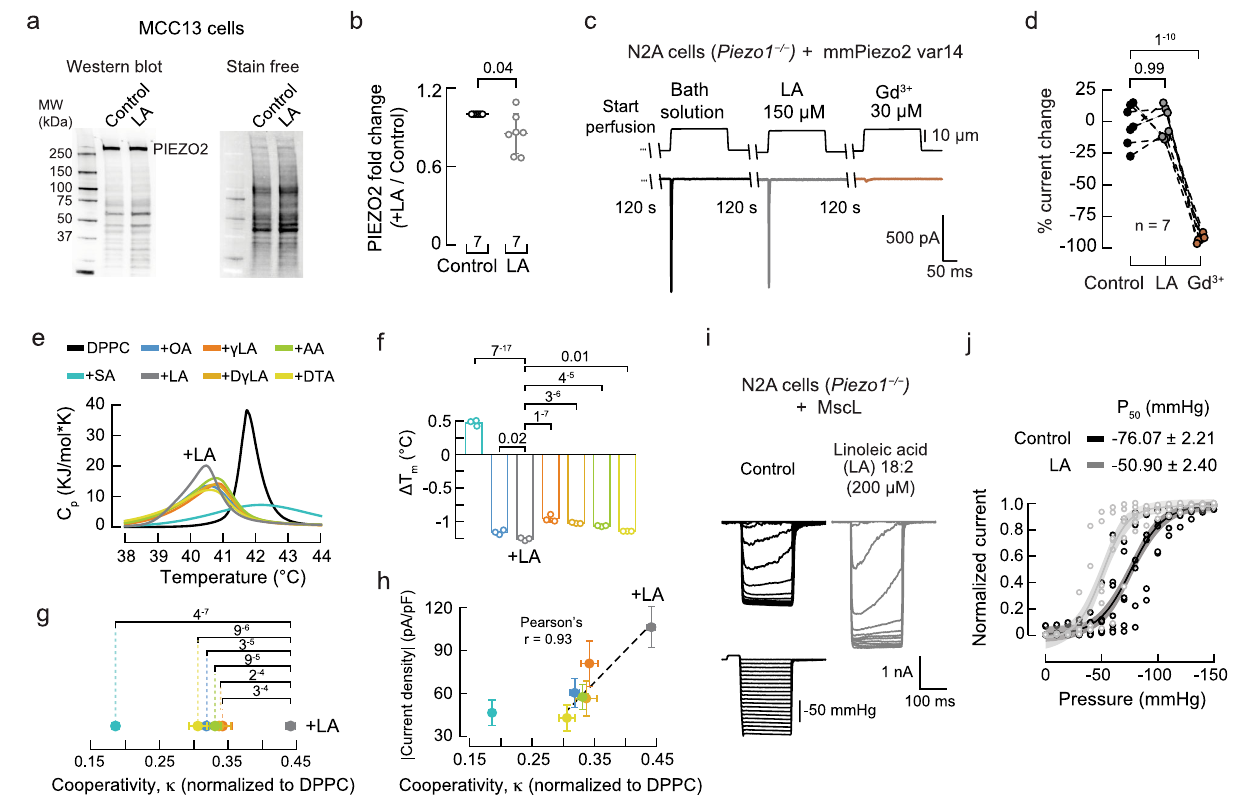
Fig. 5 | LA does not increase PIEZO2 expression but alters the physical prop- erties of the membranes. a Western (anti-PIEZO2) and stain-free blots of the membrane fractions of control and LA-treated MCC13 cells. b Mean/scatter-dot plot showing relative intensities of PIEZO2 protein normalized to the level of PIEZO2 in the control group. Lines are mean±SD. Two-tailed one-sample t -test ( t = − 2.5). c Representative currents elicited by 10 µ m displacement of Piezo2 var14 transfected cells after perfusing bath solution with LA and Gd 3+ . d Percent current changefromindependentcellsrecordedwiththeprotocolshownin( c ).Paireddata pointsrepresentindividualcells.One-sidedrepeatedmeasuresANOVA( F =186.94; p =9.51 − 6 ) and Tukey test. e Thermotropic characterization of the DPPC/fatty acid systems using DSC: control (Tm=41.75 ±0.05°C; mean ± sd), SA (42.23±0.04°C), OA (40.59±0.03°C), LA (40.53±0.06°C), γ LA (40.80±0.05°C), D γ LA (40.73±0.01°C), AA (40.79±0.01°C), and DTA (40.61±0°C). f Effects of DPPC/fatty acidsonmeltingtemperatures( Δ Tm)withrespecttoDPPCmembranes. n =3.Bars